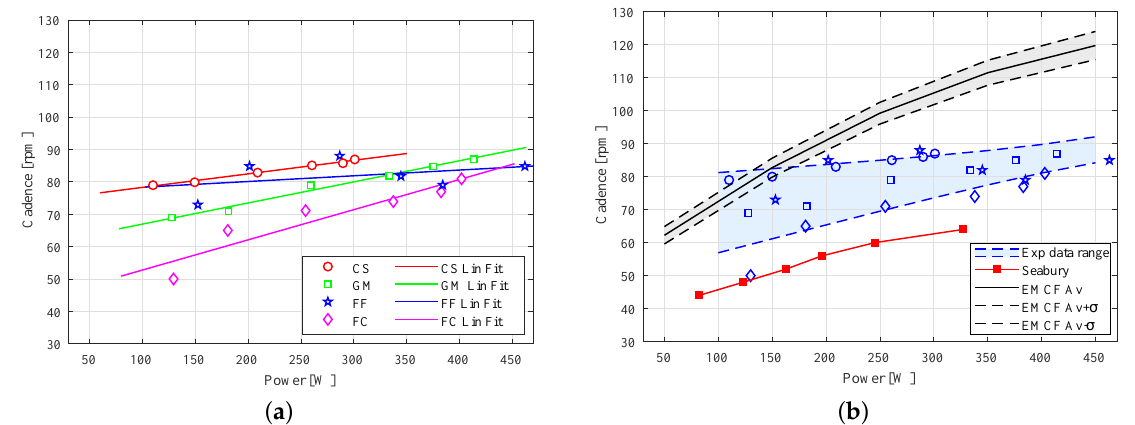
Figure 8. Results of tests: ( a ) linear fit of data for each cyclist; ( b ) trend of aggregate data versus EMCF and Seabury